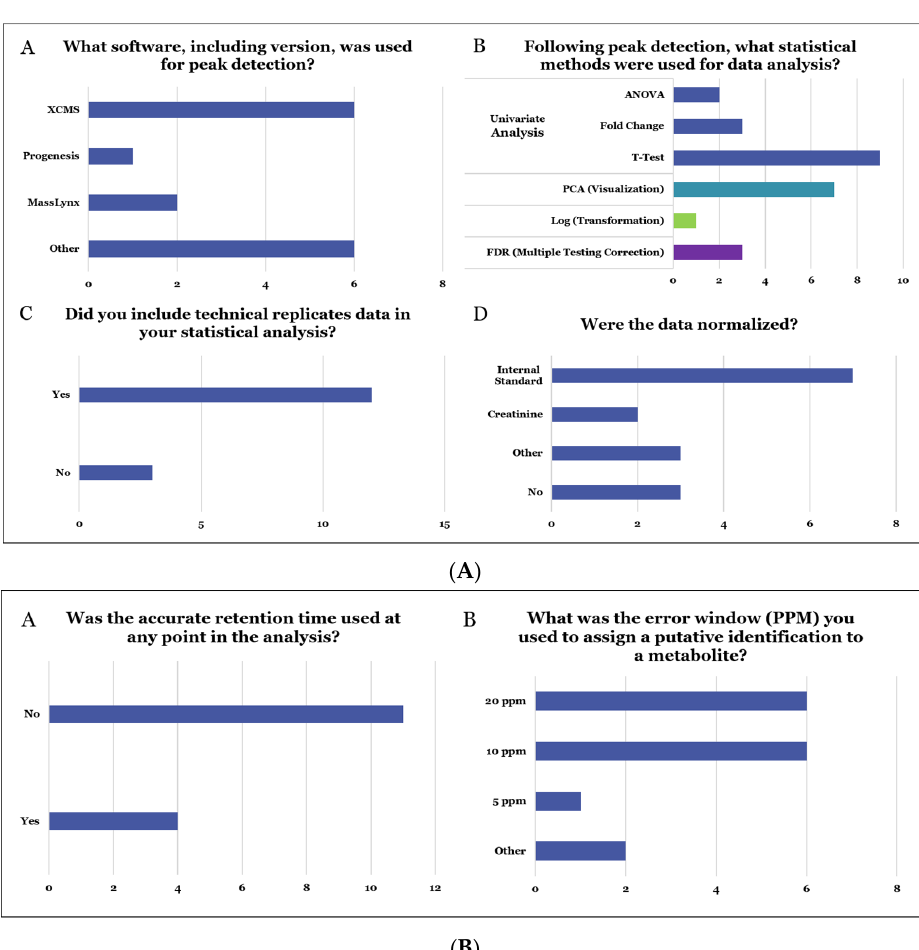
Figure 3. ( A ) Details on data analysis methodologies across participant laboratories for data processing (Panel A), statistical analysis (Panels B and C), and data normalization (Panel D). ( B ) LC-MS data parameters including RT (Panel A) and mass accuracy (Panel B) used by participants for accurate mass-based database search.